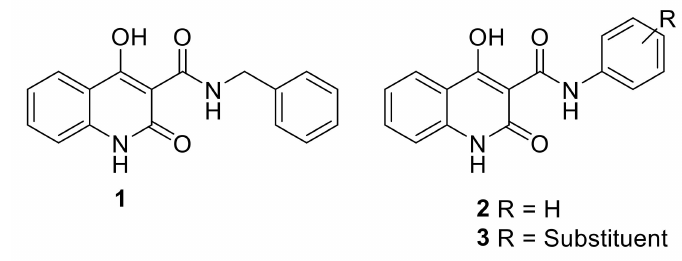
Figure 1. Chemical structures of 1 , 2 and 3 .